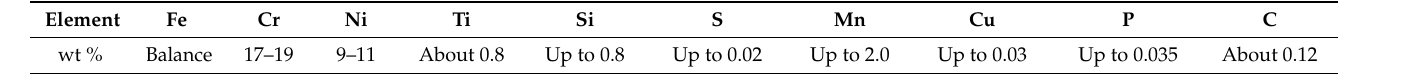
Table 4. Chemical content of 2024 (D16) duralumin, wt %.